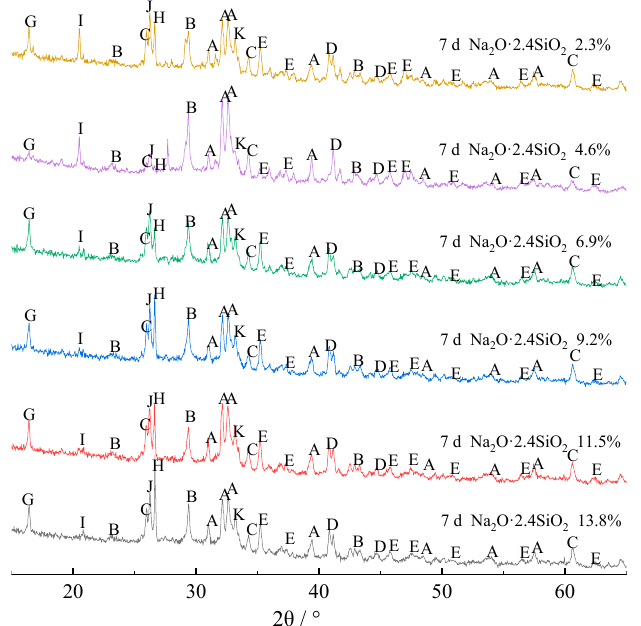
Figure 2. XRD patterns of composite alkali-activated cementitious materials after curing for 7 days. A, β -dicalcium silicate ( β -2CaO·SiO 2 ); B, calcite (CaCO 3 ); C, lawsonite (CaO·Al 2 O 3 ·2SiO 2 ·2H 2 O); D, C-S-H (xCaO · SiO 2 · (m+x − 2)H 2 O); E, boggsite (Na 3.7 Ca 7.4 Al 18.5 Si 77.5 O 192 · 74H 2 O); G, mullite (3Al 2 O 3 · 2SiO 2 ); H, tetranatrolite ((Na,Ca) 2 (Si,Al) 5 O 10 · 2H 2 O); I, beidellite (Na 0.3 Al 2 (Si,Al) 4 O 10 (OH) 2 · 2H 2 O); J, quartz (SiO 2 ); K, wairakite (CaO · Al 2 O 3 · 4SiO 2 · 2H 2 O).